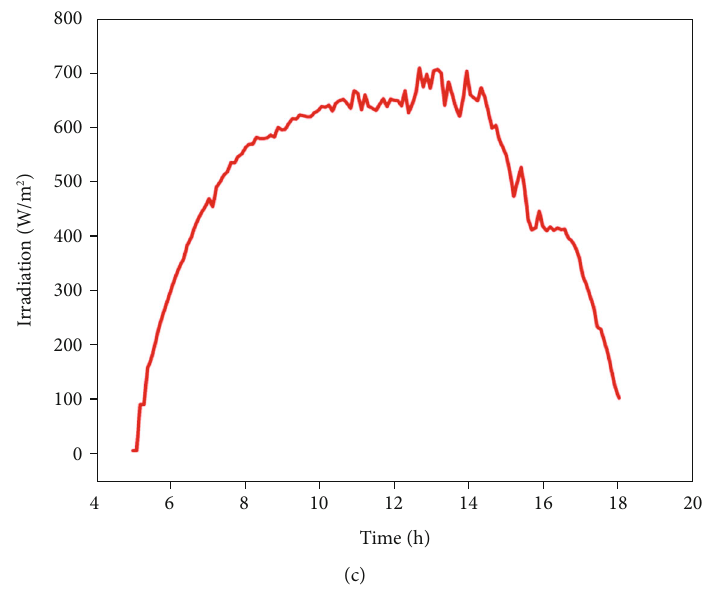
Figure 3: Initial weather data: (a) wind speed, (b) air temperature, and (c) irradiation intensity.